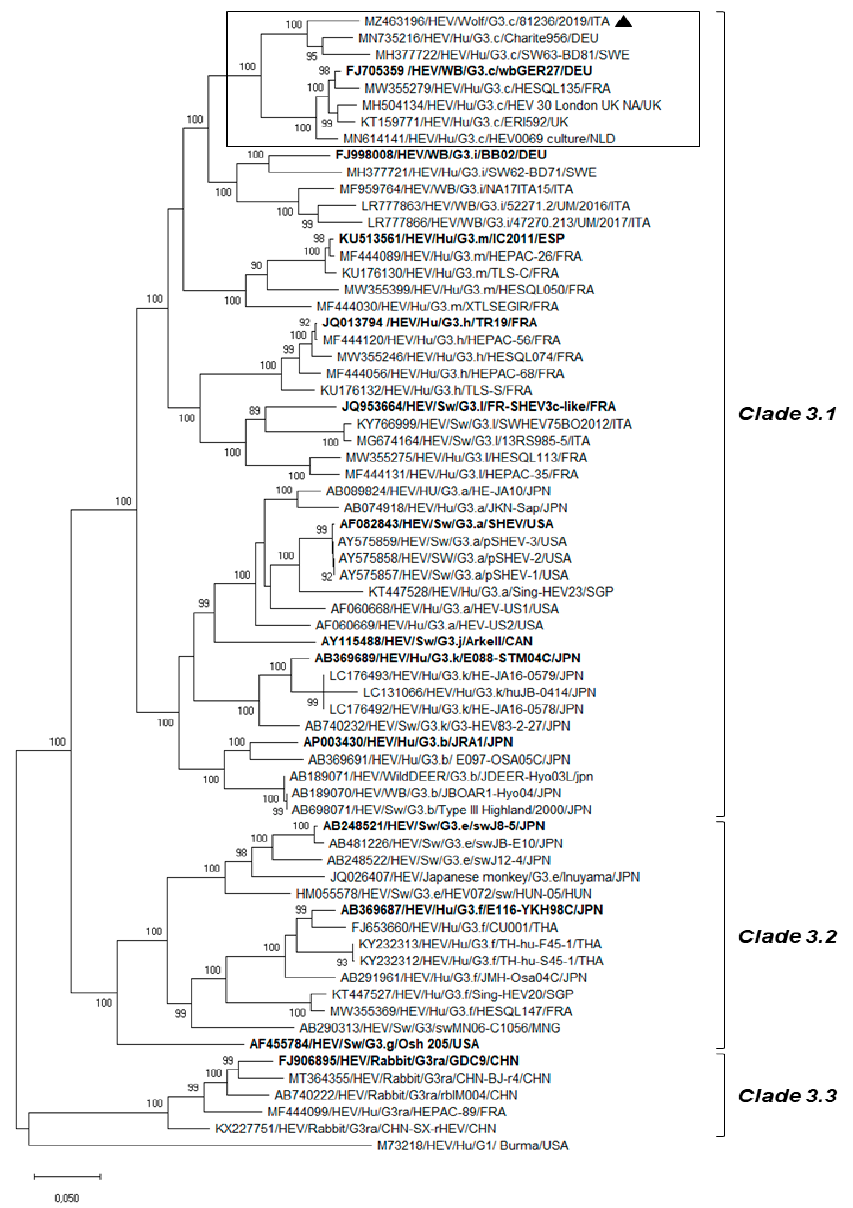
Figure 1. Phylogenetic analysis performed on the complete nucleotide sequence (7212 nt) of the strain HEV/81236/Wolf/2019/ITA (GenBank accession no. MZ463196). Tree was generated using maximum likelihood method based on the Tamura–Nei model and supplying statistical support with bootstrapping of 1000 replicates. A selection of complete genome sequences of the Orthohepevirus A species, including all the reference strains [5] representative of each HEV Gt3 subtype group (http://talk.ictvonline.org), was used for the analysis. The scale bar indicates nucleotide substitutions per site. The reference strains representative of each HEV Gt3 subtype are in boldface. HEVs classified within the subtype c were delimited by rectangle. The marker denotes the HEV sequence detected in this study. Evolutionary analyses were conducted in MEGA X [24]. Table 1. Sequence identity of the HEV/81236/Wolf/2019/ITA (GenBank accession no. MZ463196) to prototype HEV strains representative of each Gt3 subtype for which the complete genome is currently available.